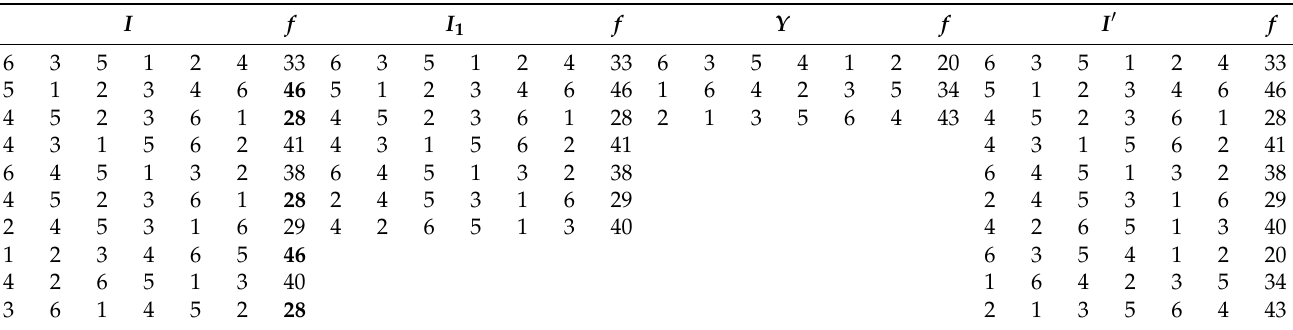
Table 3. The similarity-eliminating operation based on the route